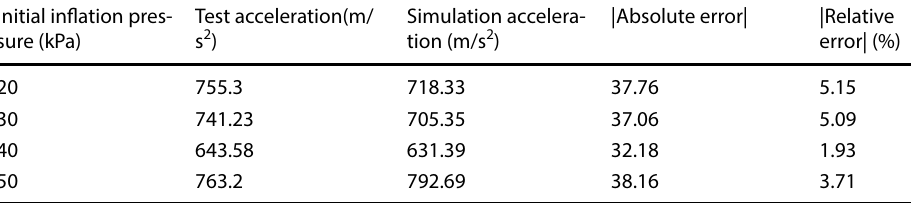
Table 6 Acceleration and error